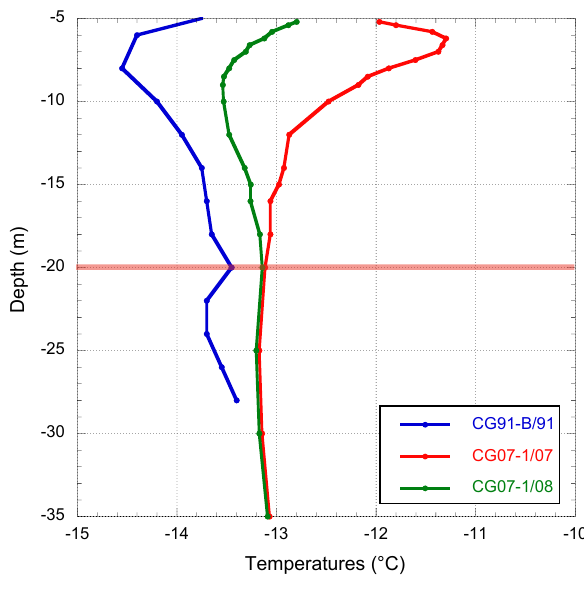
Fig. 5. Temperatures measured in CG91-B/91 (Laternser 1992), compared with the new measurements in CG07-1/07 and CG07- 1/08 at Colle Gnifetti.